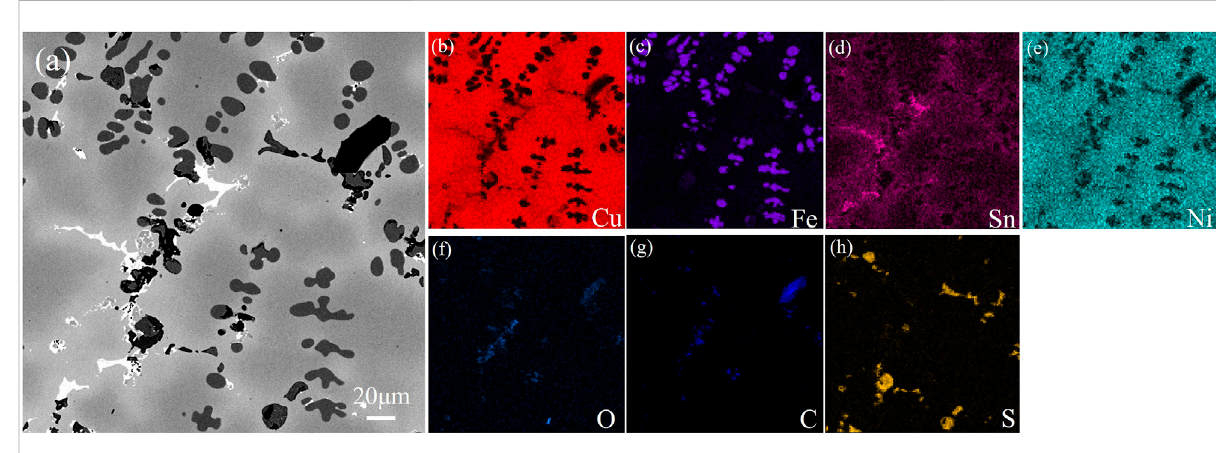
FIGURE 3 Microstructure and EDS distribution of alloy obtained by melting the circuit board.